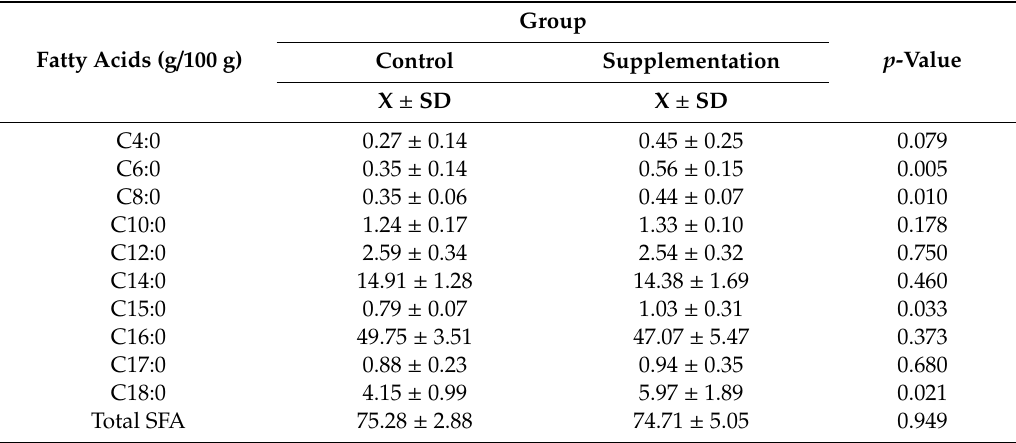
Table 3. Saturated fatty acids (SFA) profile (mean ± SD) in colostrum from Charolaise cows assigned to control (n = 10) and supplementation (n = 10; diet supplemented with soy lecithin) group. Fatty Acids (g / 100 g)